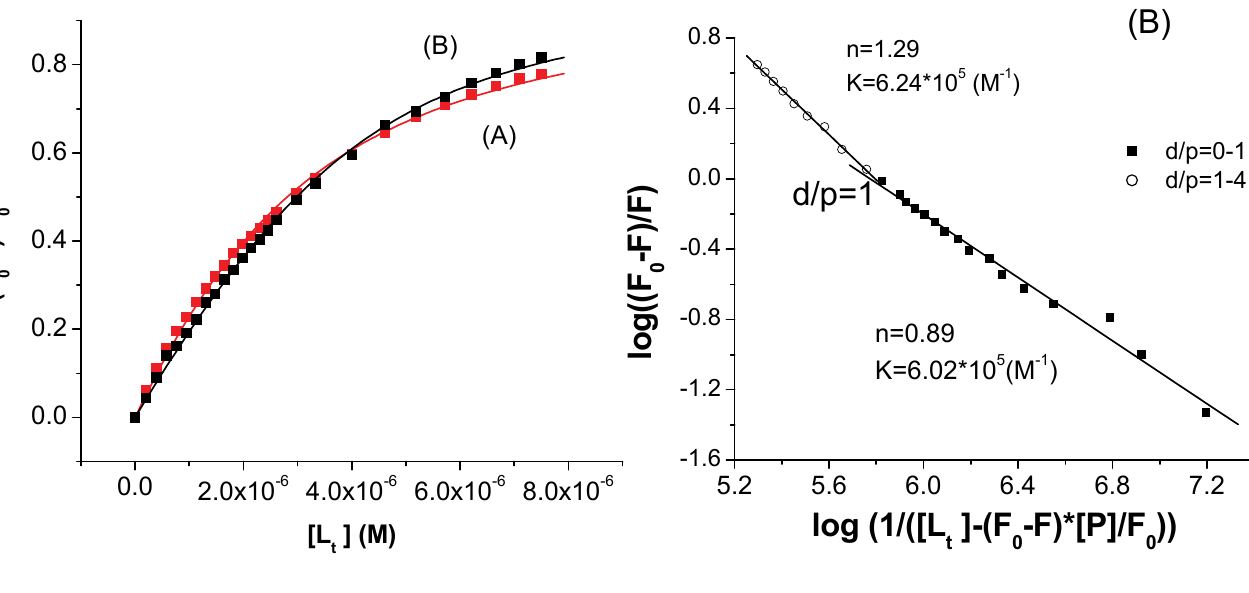
Figure 6. Nonlinear fitting of experimental data for the system (A) HSA– I (r 2 = 0.998) and (B) BSA- I (r 2 = 0.996) to Equation (7).